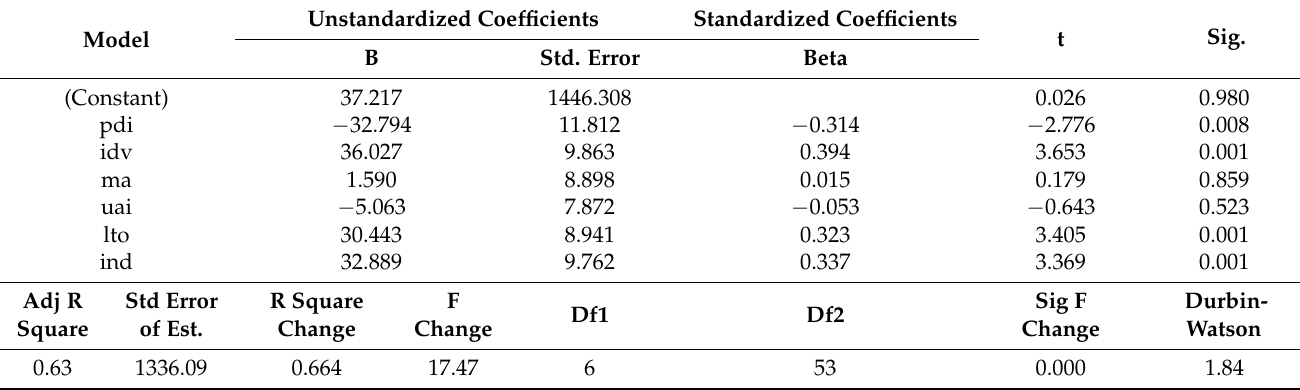
Table 4. Per Capita Health Care Spending Model 2: Regression